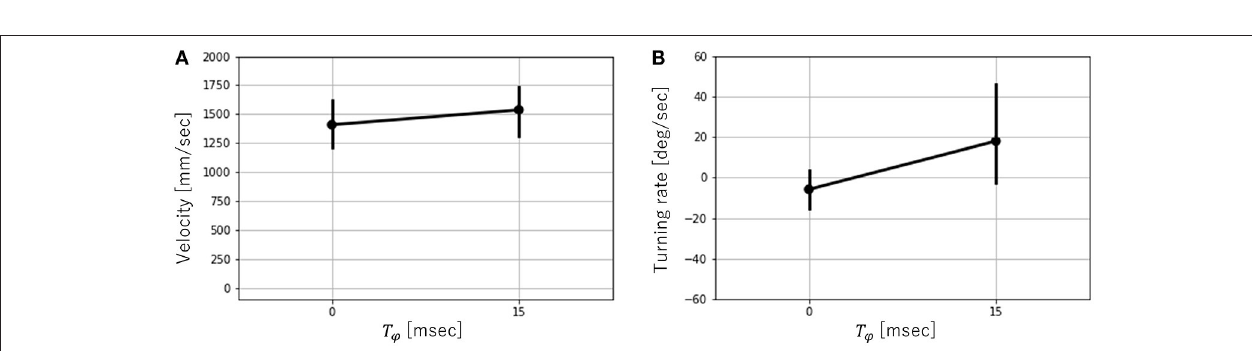
Frontiers in Robotics and AI |